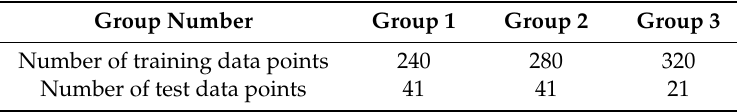
Table 1. Dataset details of comparison